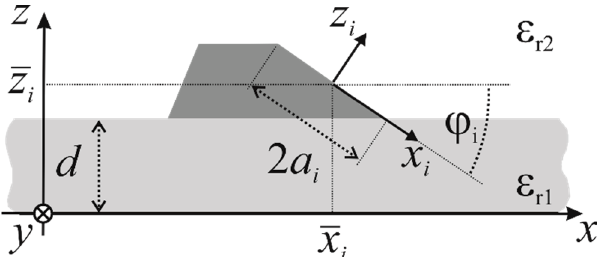
Figure 1. Geometry of the problem.